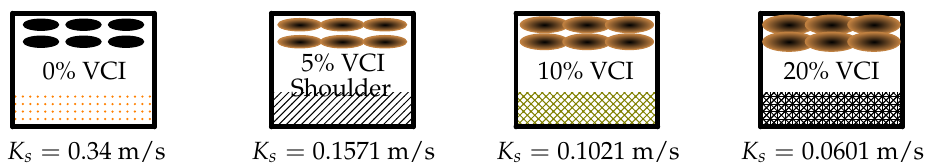
Figure 13. Models of realistic railway ballast including fouling following [3]. The layers of colour coding correspond to different values for the conductivity, and they are given in Figure 14.